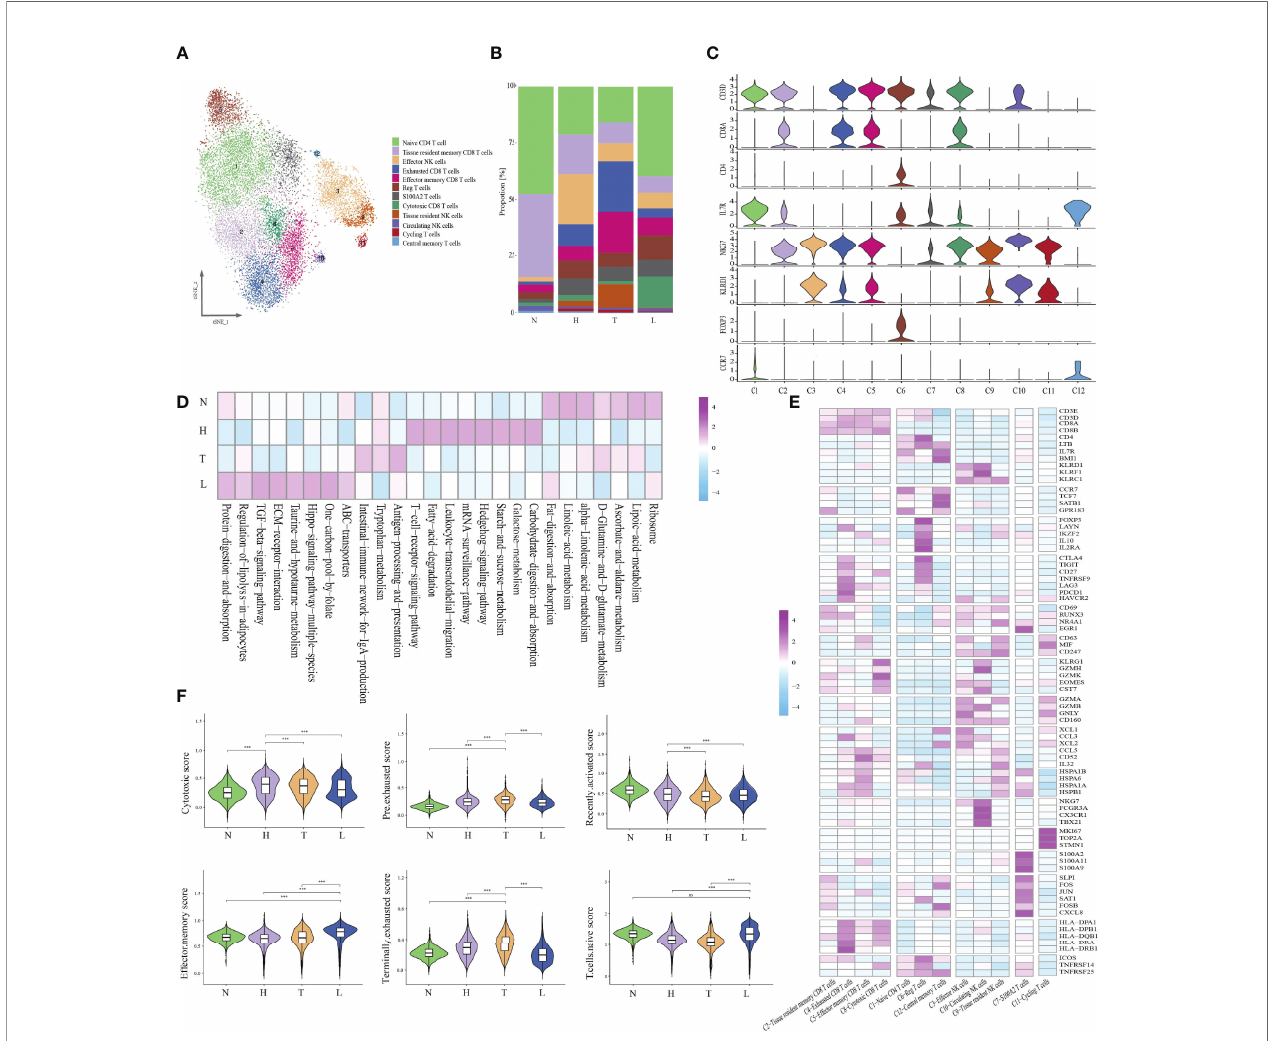
FIGURE 2 | Identifying distinct NK/T cell clusters in all samples. t-SNE projection of 12 subsets of NK/T cells (each dot corresponds to one single cell) (A) . Proportions of all cell types clusters in each group (B) . Violin plots presenting the distribution module score for selected genes for each group (C) . Heatmap indicating the expression of selected gene sets in NK/T subtypes (D) . Heatmap indicating the enrichment of signaling pathway in four groups (GSVA KEGG) (E) . Violin plots showing the scores of functional modules for four groups, using the AddModuleScore function. Error bars indicated the means ± SD. (***P < 0.001). NS, no signi fi cant (F)